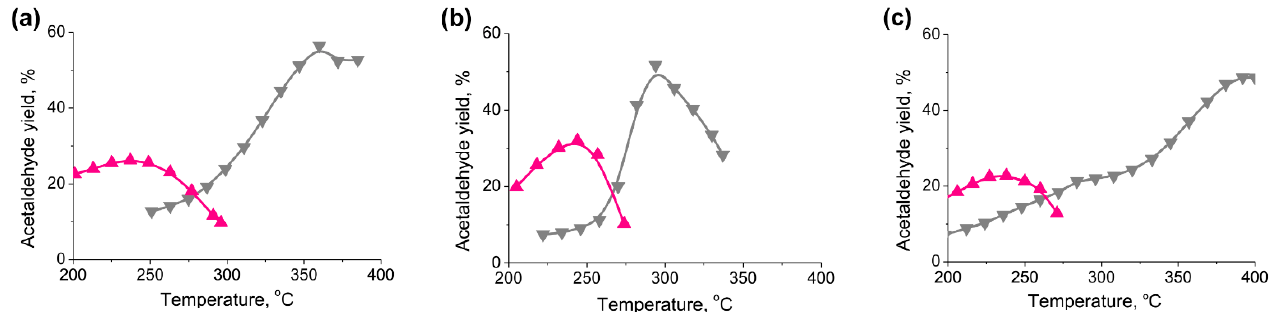
Figure 8. Yields of acetaldehyde over ( a ) Co@NC-Gr, ( b ) Co@NC-ZIF and ( c ) Co@NC-ZIF SA catalysts as a function of temperature. For feed compositions: 2 vol.% EtOH, 18 vol.% O 2 , He balance ( ▲ ); 5 vol.% EtOH, He balance ( ▼ ) ; GHSV ≈ 18,000 h − 1 .